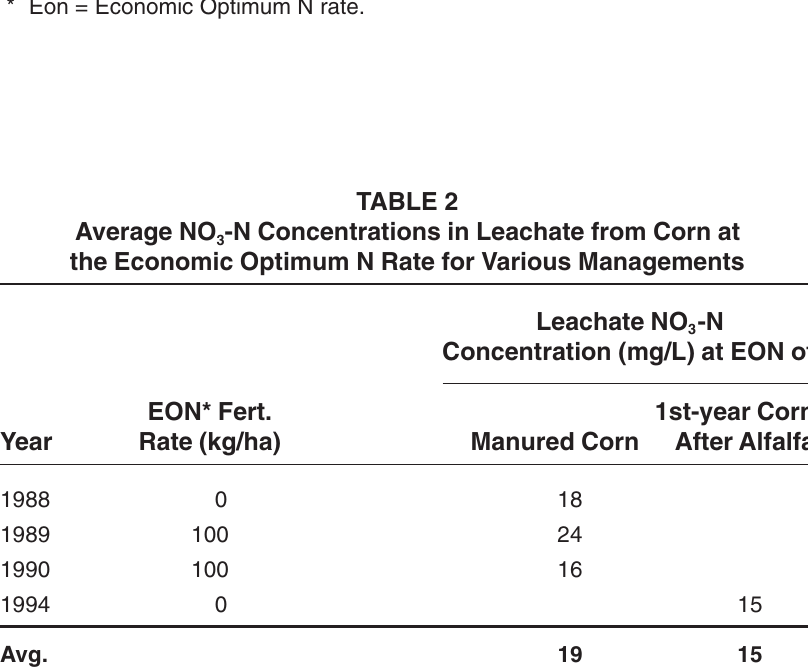
-N Concentrations in Leachate from Corn at Average NO 3 the Economic Optimum N Rate for Various Managements